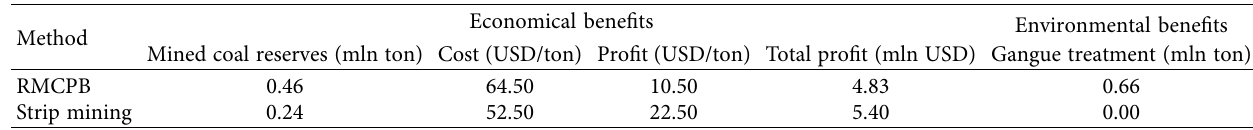
Table 4: Integrated benefit